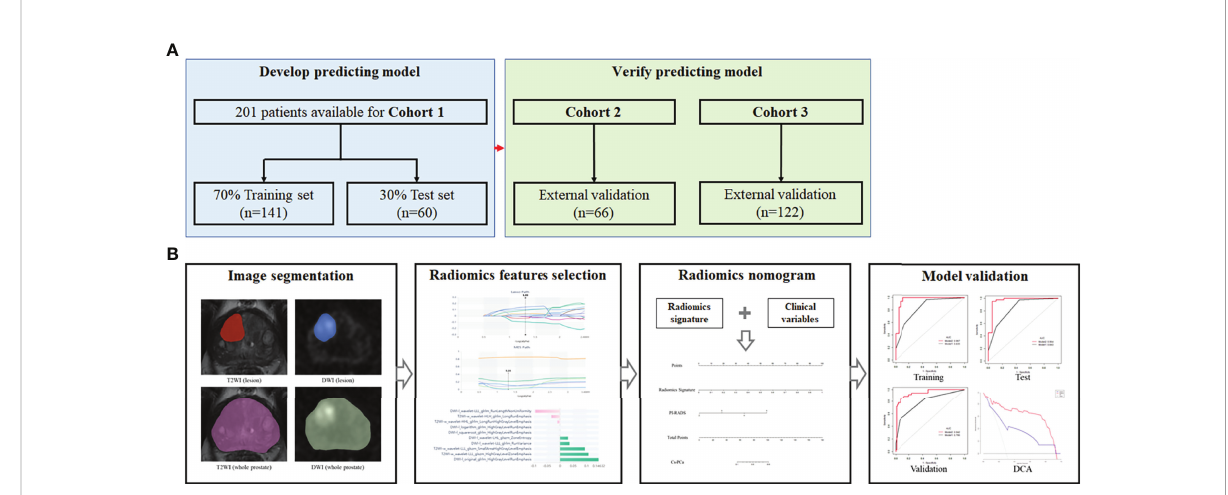
FIGURE 1 Study fl owchart and nomogram work fl ow. (A) Study fl owchart. Cohort 1, Changhai Hospital; Cohort 2, Ruijin Hospital Luwan Branch; Cohort 3, 989th Hospital of the joint logistic support force of the Chinese People ’ s Liberation Army. (B) Work fl ow for nomogram